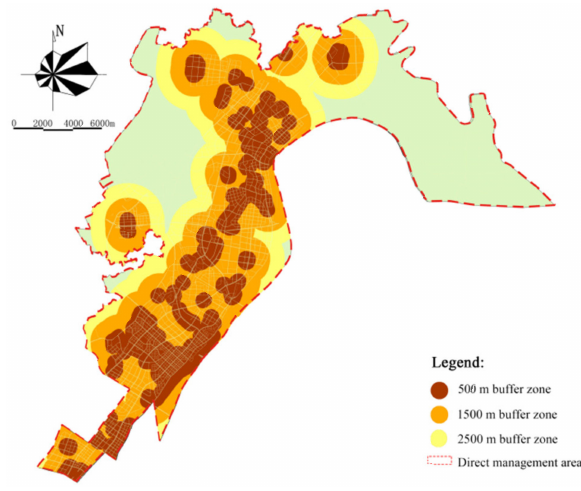
Figure 4. Multi-ring buffer zone analysis of public landscape greenspace.